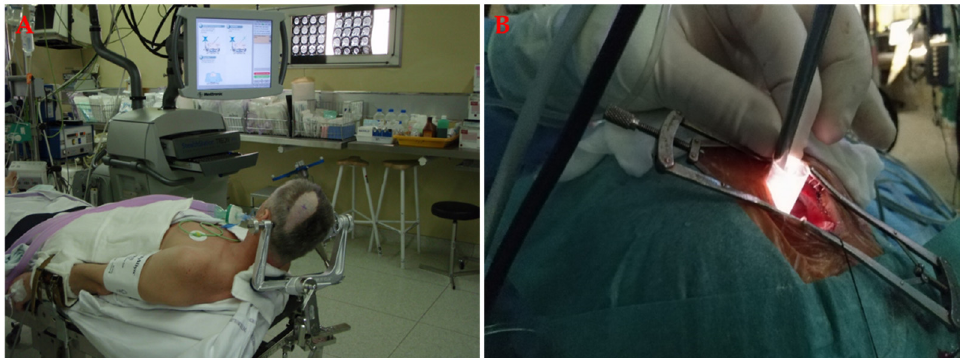
Figure 6. Keyhole craniotomy for primary tumours, which is a modification of the conventional craniotomy. ( A ) The patient is positioned, and the neuronavigation is prepared for guidance. Because less anatomy is visible on the surface, image guidance is essential. ( B ) The insertion of the instruments for tumour resection through the keyhole craniotomy. With this technique, the morbidity associated with access is minimized, as is the complication rate.